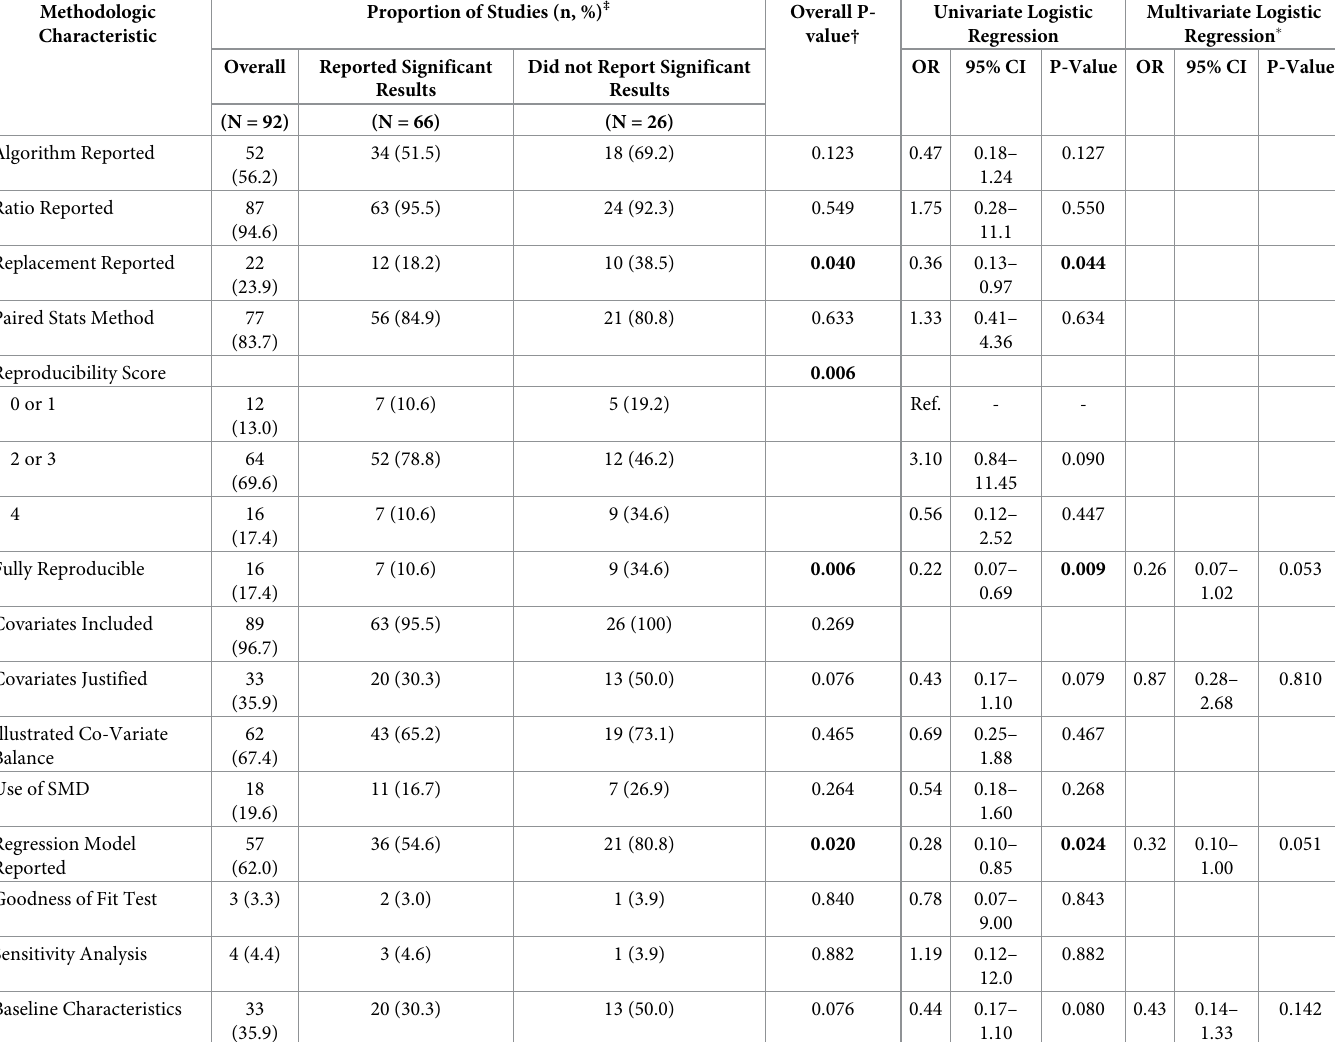
Table 5. Associations between PSM methodology reporting and statistical significance of primary